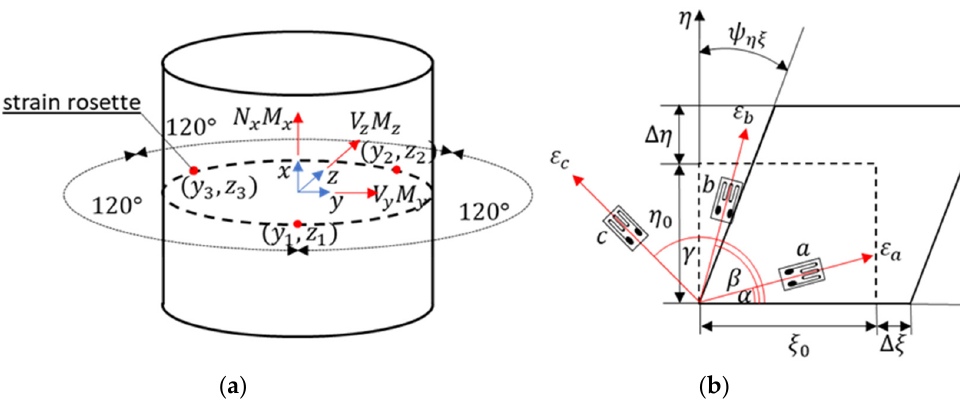
Figure 4. ( a ) Cross-section along a tubular steel wind turbine tower with three strain rosettes positioned around the section’s circumference marked as red dots and ( b ) illustration of the strain rosette applied on the surface of the steel tube consisting of three strain gauges marked as a , b and c . Each strain rosette consists of three strain gauges a , b and c , with a local coordinate system with coordinates ( ξ i , η i ) , where the ξ i -axis is pointing in the tangential direction of the outer surface of the tube and the η i -axis is aligned with the global x -axis (Figure 4b). The top view of the cross-section, together with the measuring positions as red dots, are shown in Figure 5.